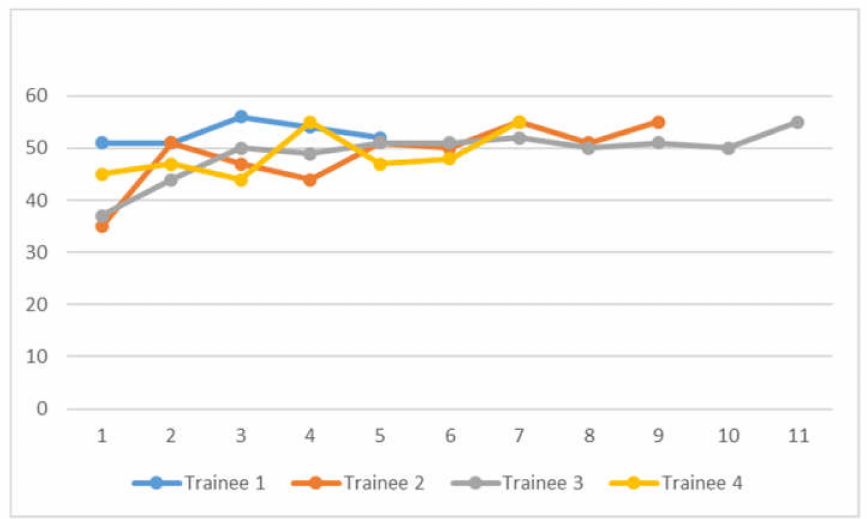
Figure 2. EUSAT Score plot of 4 Bronchoscopists performing EUS-B